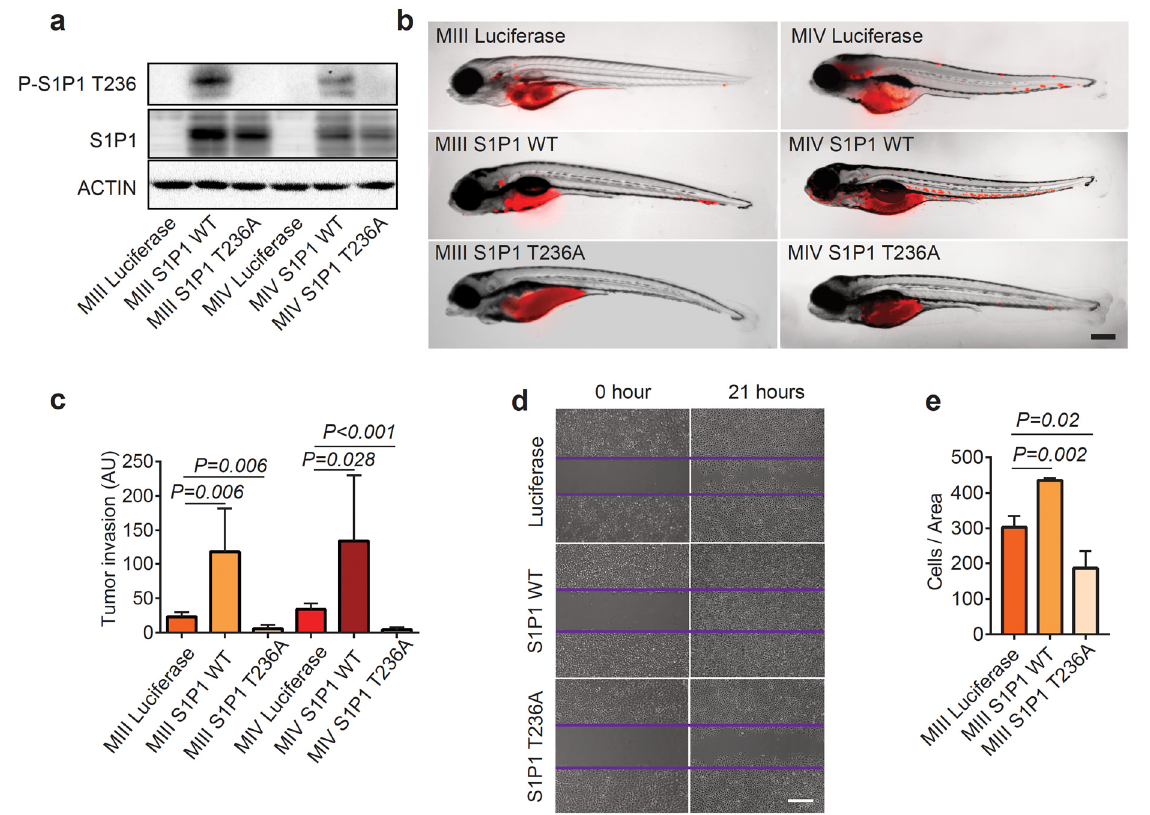
Figure 3. P-S1P1 T236 contributes to the distant spread of TNBC. ( a ) Western blotting analysis of P-S1P1 T236, S1P1, and ACTIN in MIII and MIV cells overexpressing Luciferase, S1P1 WT, or the phosphorylation-defective S1P1 T236A mutant. ( b ) Overlay of brightfield and red fluorescence images of zebrafish xenografts transplanted with RFP + MIII and MIV cells overexpressing Luciferase , S1P1 WT , or S1P1 T236A at 3 dpt (right panel). ( c ) Quantification of invasive properties of MIII and MIV cells overexpressing Luciferase , S1P1 WT , or S1P1 T236A in zebrafish xenografts based on fluorescence intensity of RFP + tumor cells outside of the initial injection area ( n = 6 for MIII and MIV overexpressing Luciferase , and n = 3 for MIII and MIV overexpressing S1P1 WT or S1P1 T236A ). ( d , e ) Wound-scratch assay ( d ) and quantification ( e ) show increased migration properties of MIII cells overexpressing S1P1 WT though not S1P1 T236A at 21 h after wound scratch, compared to control Luciferase-overexpressing cells ( n = 3 per group). Data are presented as Mean ± SEM. Scale bar = 200 µ m in ( b ) and Scale bar = 5 µ M in ( d